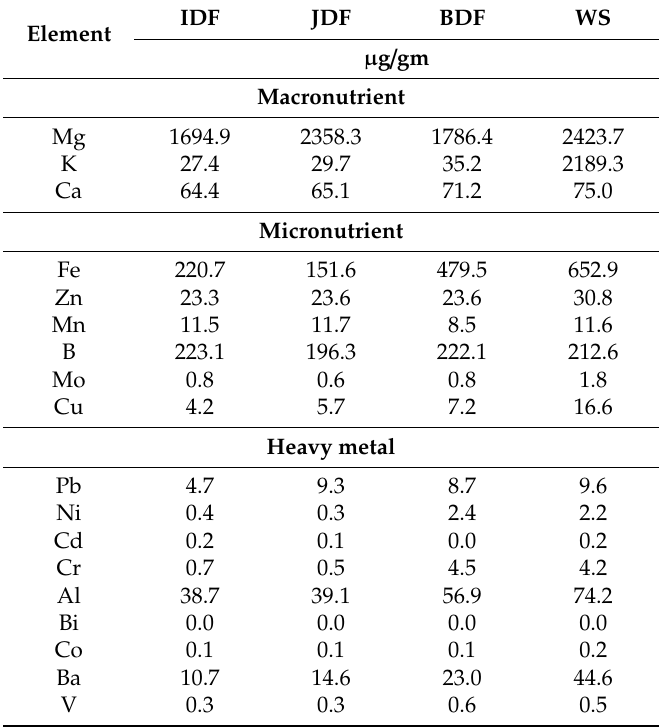
Table 6. Nutrient content present in Wheat straw, Indigenous cow dung fiber (IDF), Jersey cow dung fiber (JDF), and Bu ff alo dung fiber